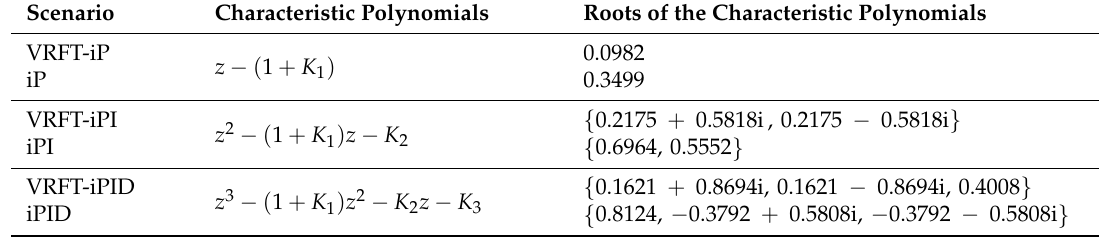
Table 4. The characteristic polynomials and the roots resulted from Equation (7).